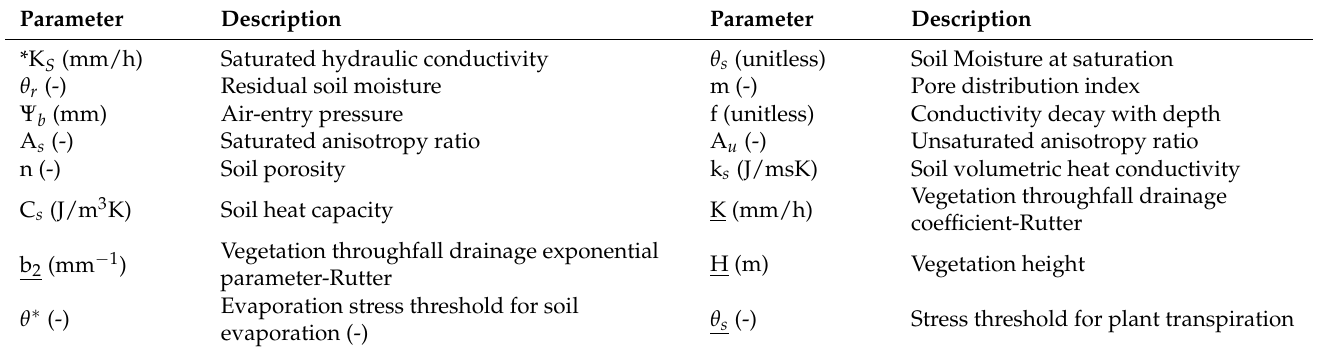
Table 5. tRIBS static calibrated soil and vegetation (underlined)